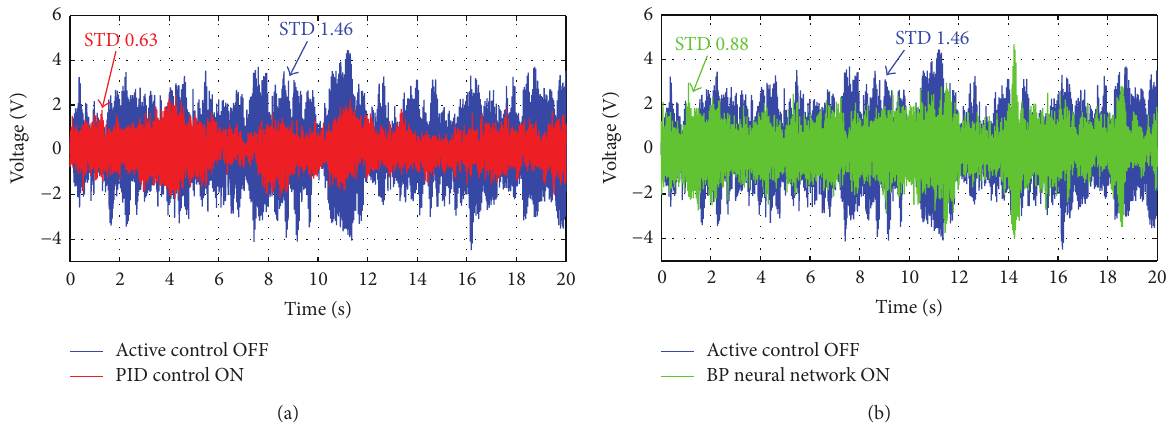
Figure 18: Time plots of balance signals with active control ON/OFF at V = 25 m/s, (a) for PID control and (b) for BP NN control.